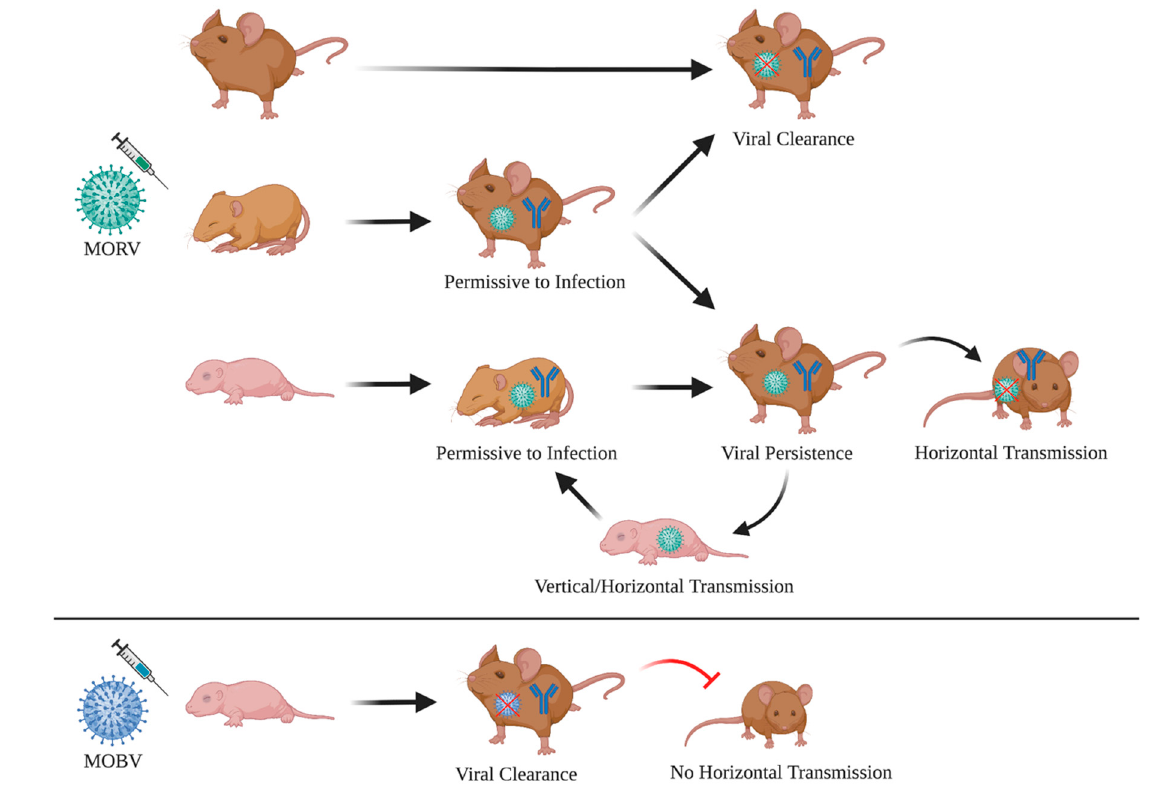
Figure 4. Schematic summary of the findings. Susceptibility of Mastomys to MORV infections is age-dependent. Neonates are permissive to the infection, can become chronically infected and transmit the virus horizontally, leading to more chronically infected animals. Adults and weaned individuals are permissive to the infection with MORV but clear the virus within a few weeks. Infected juveniles show a mixed phenotype with some individuals remaining long-term infected and some clearing the virus, although at a slower rate compared to adults. All animals that are in contact with the virus develop IgG antibodies, independent of their infection status. MOBV-inoculated neonatal Mastomys , on the other hand, show only transient viremia, clear the virus rapidly and are unable to transmit the virus. The figure was created by BioRender.com.